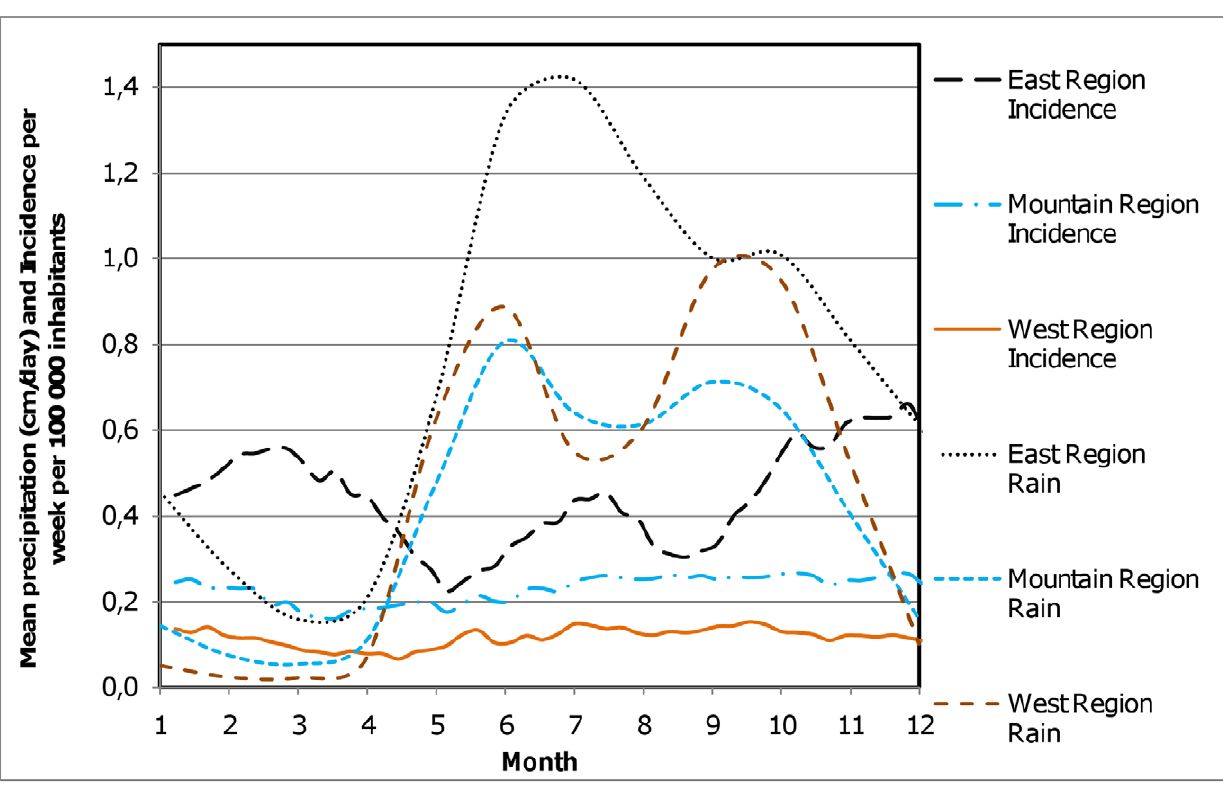
Figure 5. Seasonal distribution of rain and snakebites in three regions in Nicaragua. The regions are aggregations of the regions in Figure 2. East Region = East Inland and Coast, West Region = West Coast North, Central, High and South. In order to produce a smooth graph line, the seasonal variation is shown as a sliding one-week mean of the week, the two previous and the two following weeks (a total of five weeks).